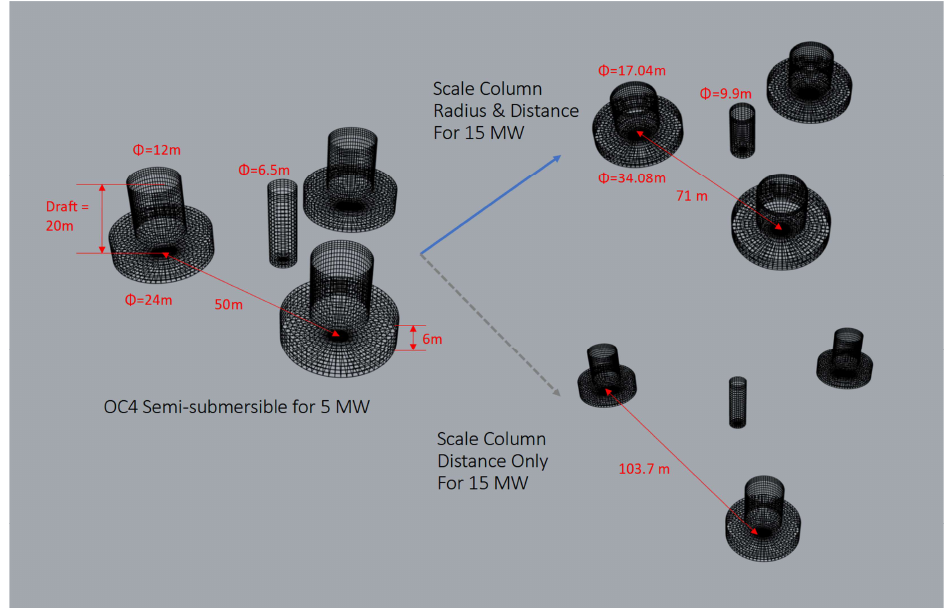
Figure 4. Example Mesh of OC4 Semi-submersible; 15 MW Semi-submersible, upscaled in distance and radius; and 15 MW Semi-submersible, upscaled in distance only.